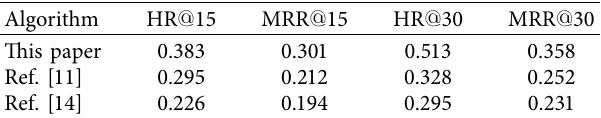
Table 4: Performance comparison of three algorithms on Tokyo data